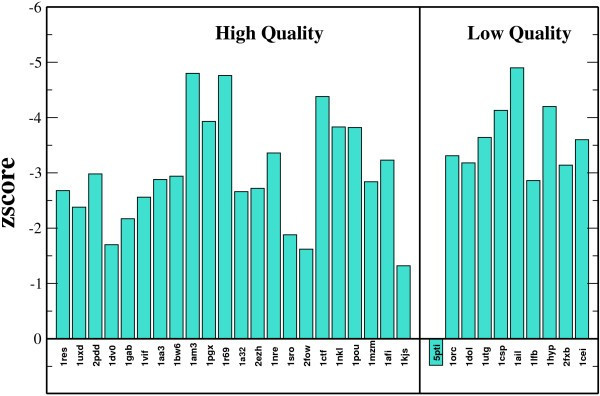
Z-scores. Z-scores for independently generated near-native conformations of of the proteins investigated. The Z-score is computed as the ratio of the energy difference between the near-native decoy to the mean of the decoy set, divided by the standard deviation of the letter. The relaxed energies were used for mean and standard deviation.